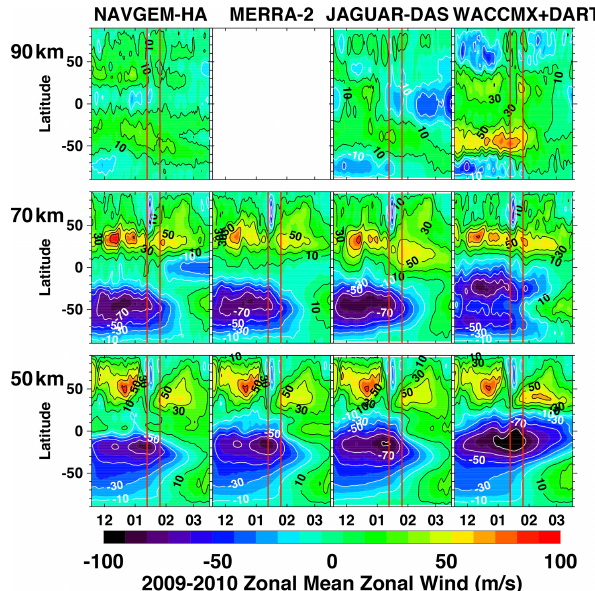
Figure 8. As in Fig. 7 but for zonal wind. Contours are drawn every 20ms − 1